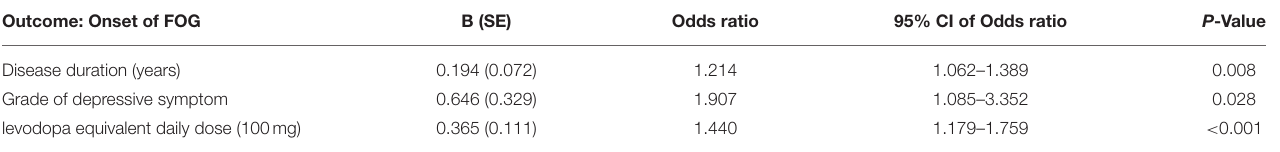
TABLE 2 | Regression coefficients of the final model.